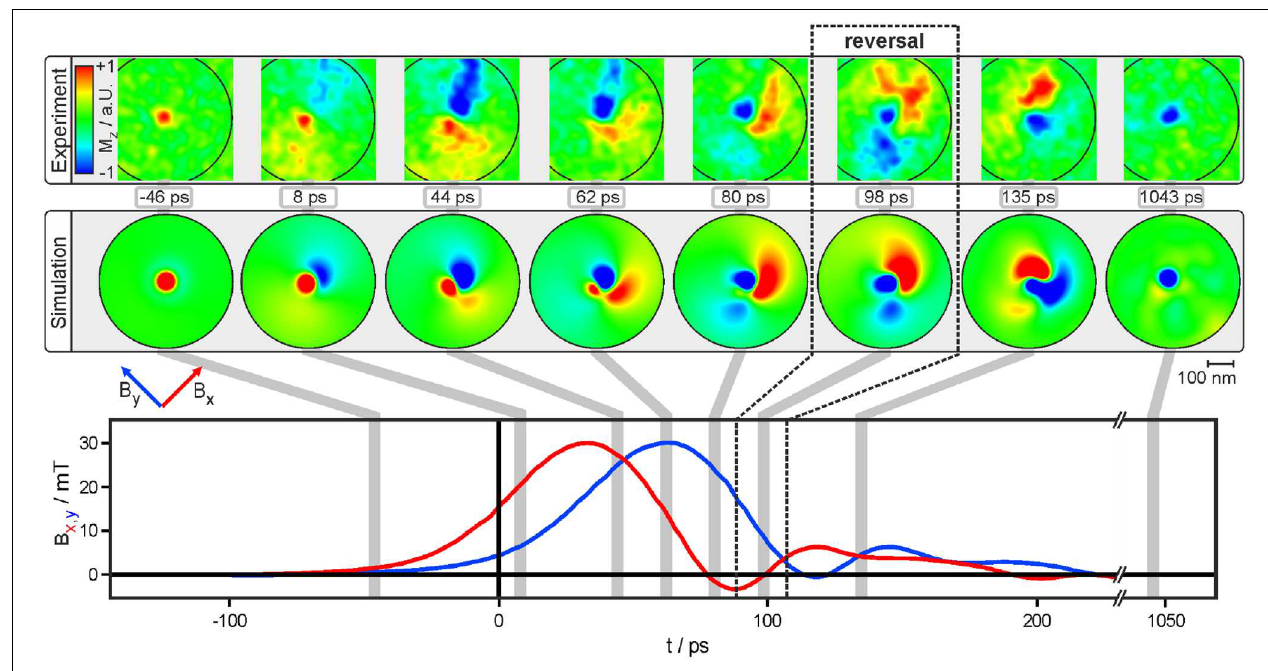
FIGURE 5 | Imaging of the vortex core reversal process by the excitation with orthogonal magnetic field pulses, experiment and micromagnetic simulation [34]. Pulse amplitude: 30 mT, pulse width 60 ps, total duration of the excitation: 90 ps (see lower row). The upper row shows the dynamic response of the out-of-plane